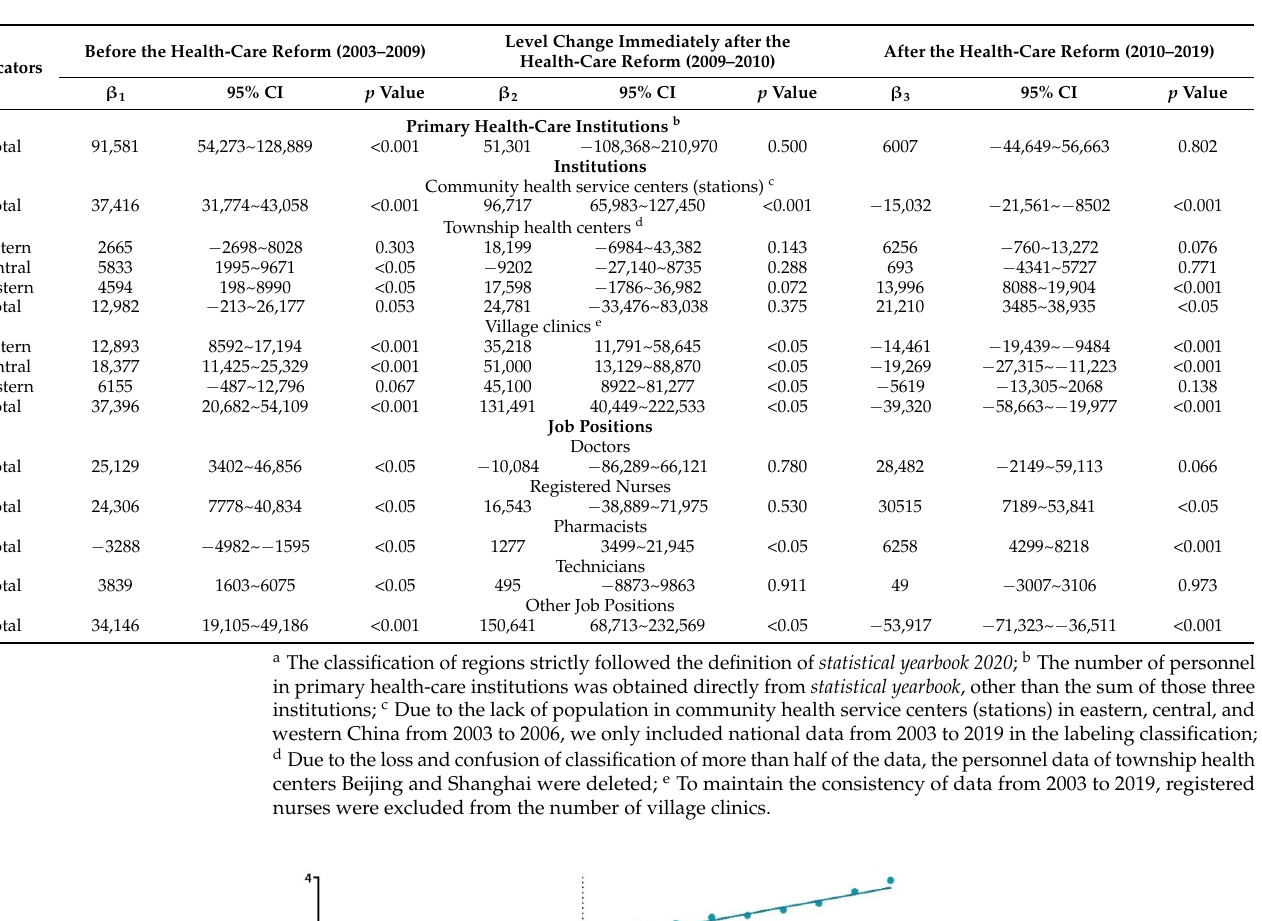
Table 2. Interrupted time series analysis of changes in the number of personnel in primary health-care institutions in China from 2003 to 2019 a .